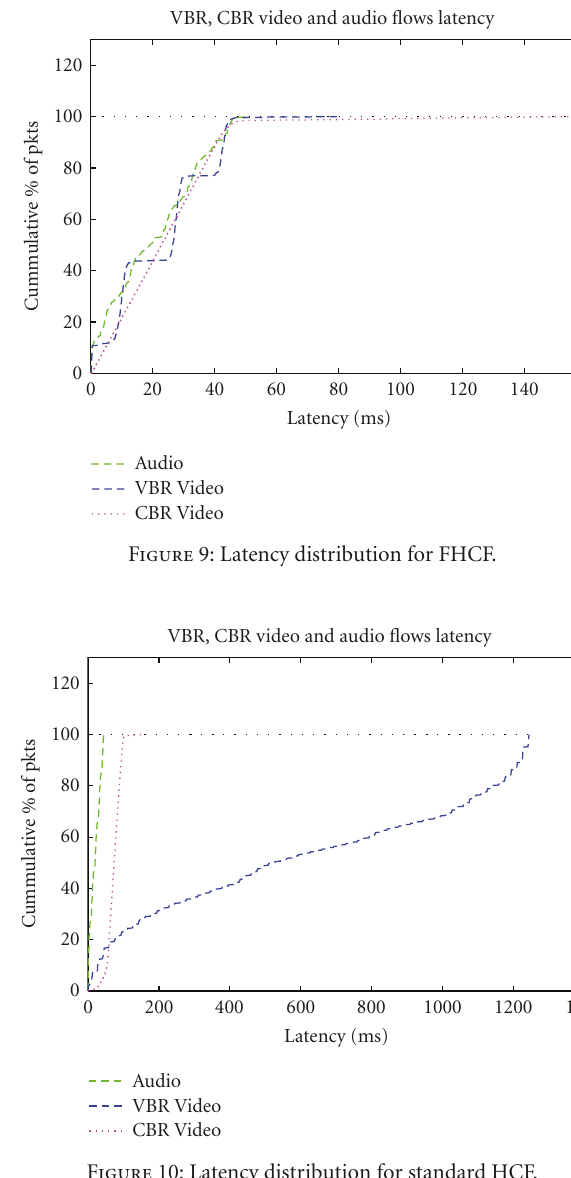
Figure 10: Latency distribution for standard